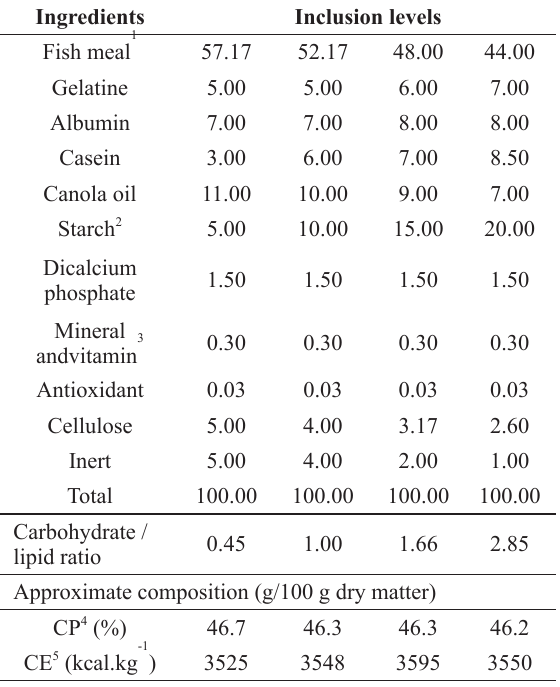
Composition of the experimental